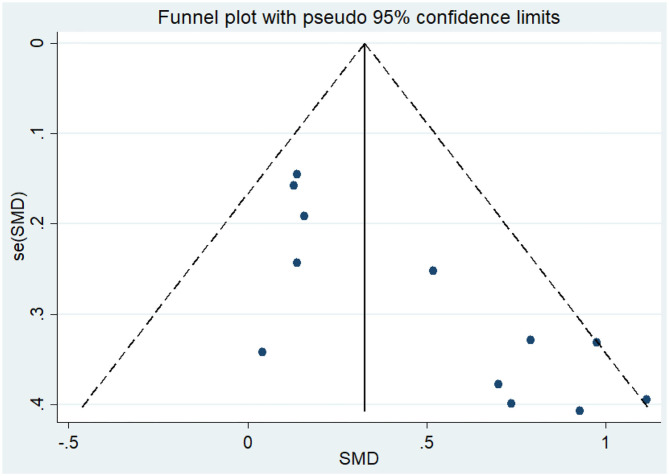
Funnel plot of publication bias for executive function.